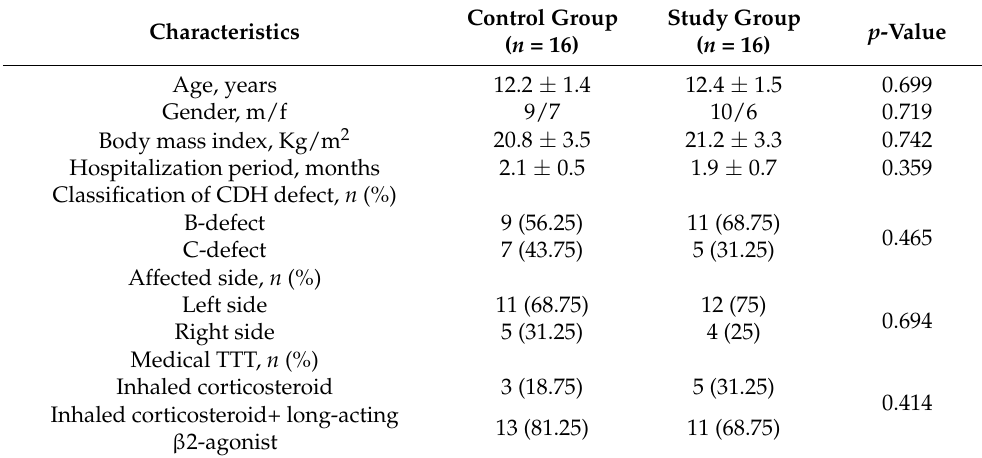
Table 1. Demographic and clinical